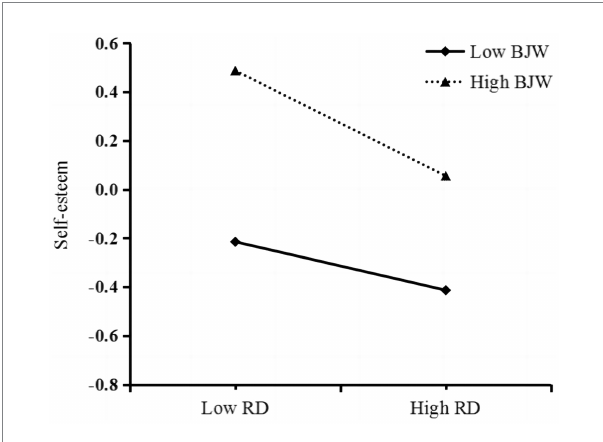
FIGURE 3 Moderating effect of relative deprivation on the prediction of self- esteem. RD, relative deprivation; BJW, belief in a just